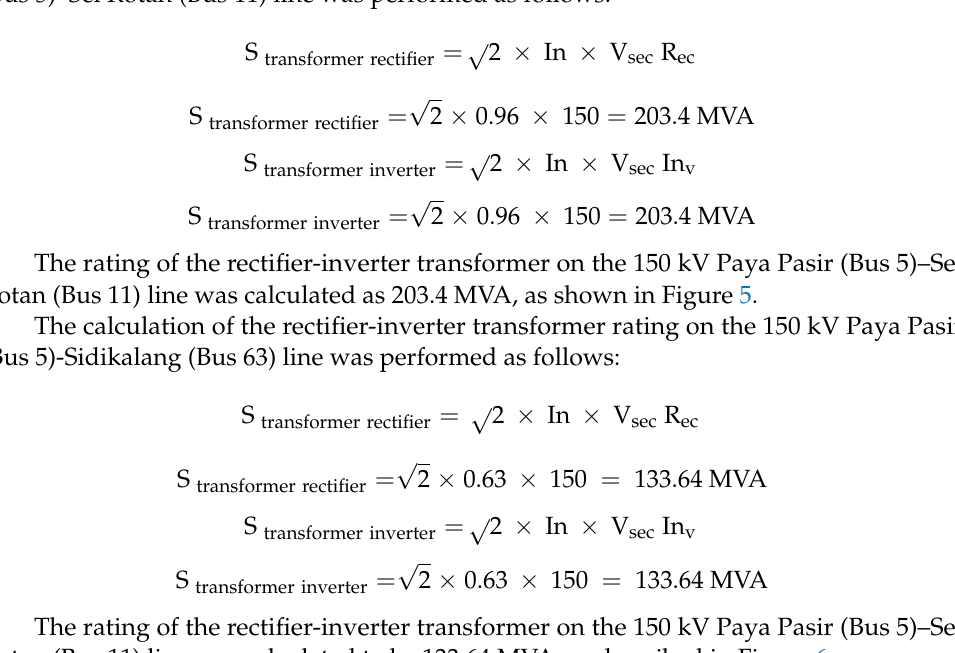
The rating of the rectifier-inverter transformer on the 150 kV Paya Pasir (Bus 5)–Sei Rotan (Bus 11) line was calculated to be 133.64 MVA, as described in Figure 6. After determining the rectifier-inverter transformer ratings, the transmission line voltage was lowered to 20 kV on the HVDC line through the rectifier and returned to 150 kV again after passing through the